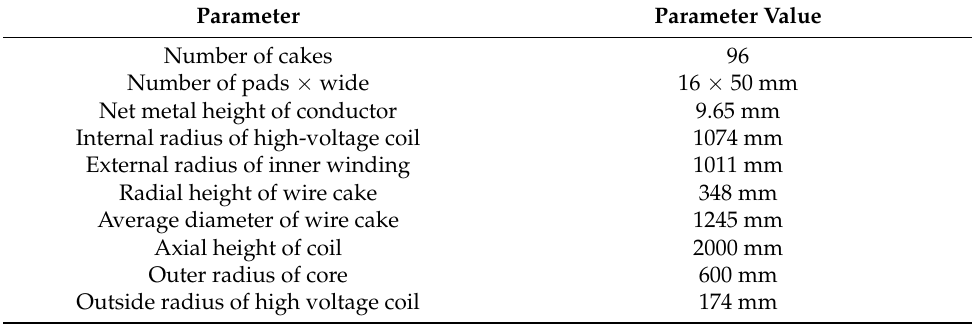
Table 3. Structural dimension parameters of high voltage windings.